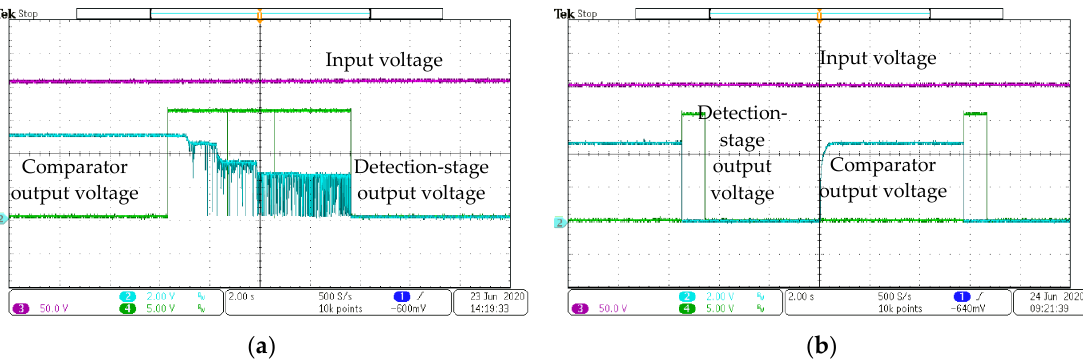
Figure 10. Working principle waveforms of the bipolar current angular transistor command under slow slope changes of the input voltage: ( a ) no stabilization method (no R h resistance) and ( b ) with a feedback stabilization method (with R h resistance).